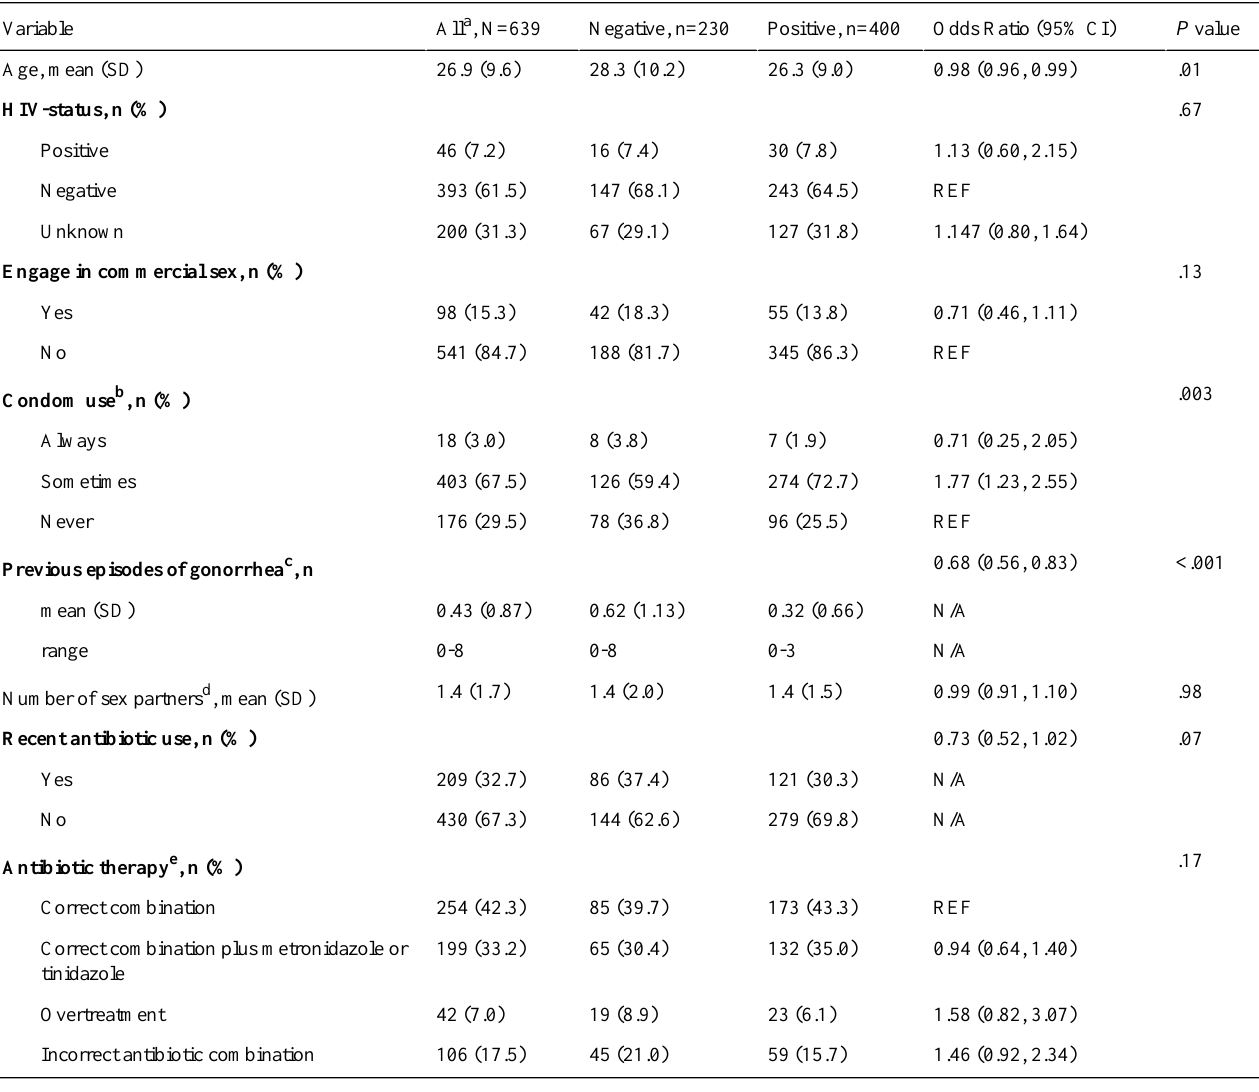
Table 5. Variables by gonorrhea